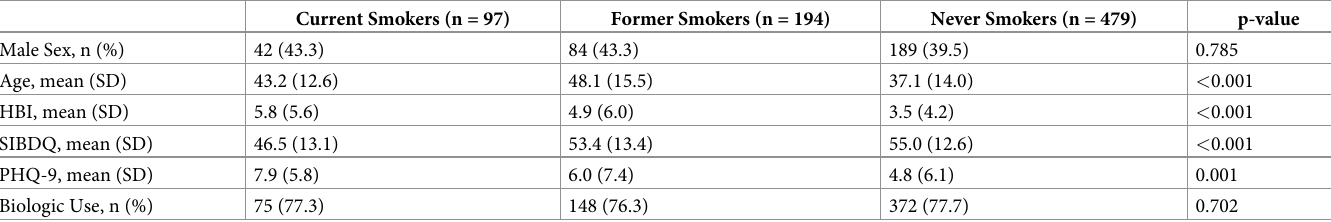
Table 1. Baseline demographics and disease indicators in current, former, and never smokers with Crohn’s